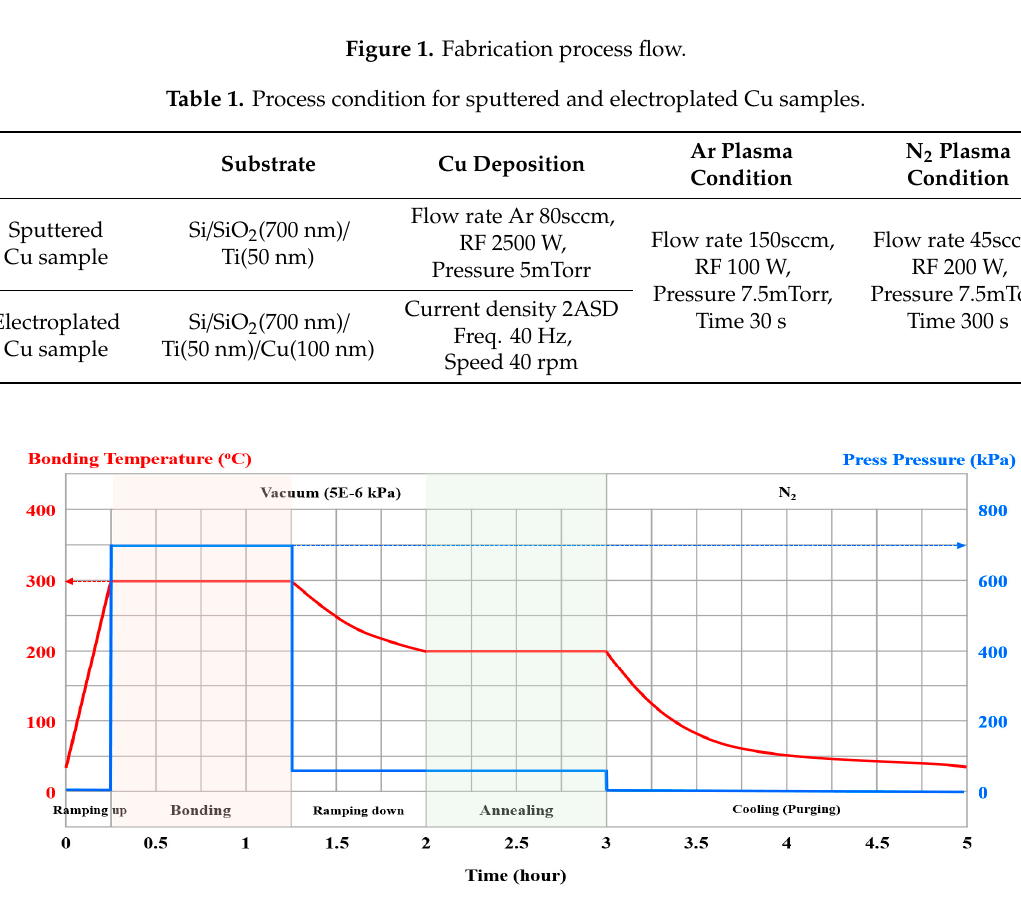
Figure 2. Bonding process profile.